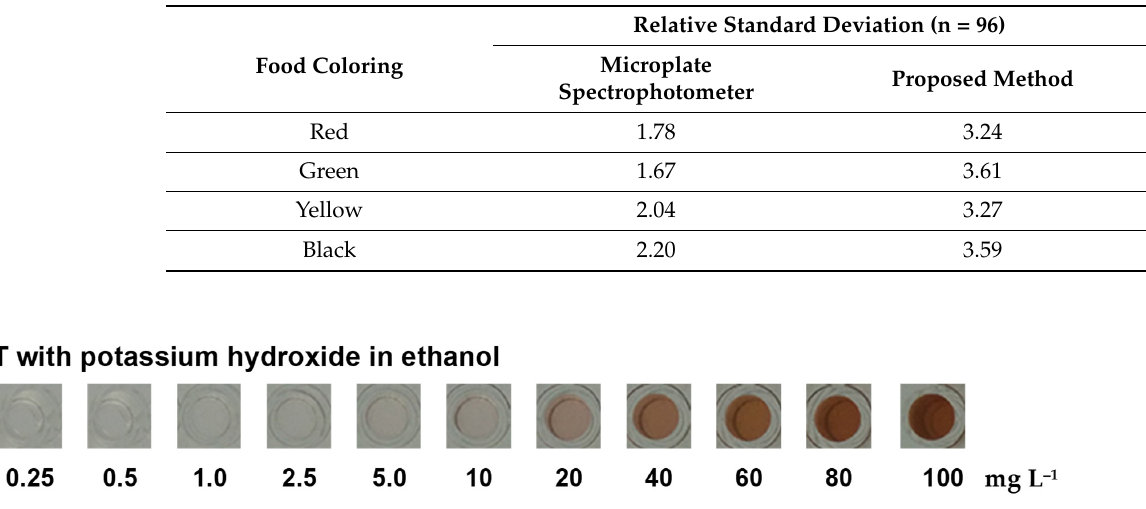
Table 1. The relative standard deviations of the proposed method and microplate spectrophotometry for four food colorings at a concentration of 80 mg L − 1 .